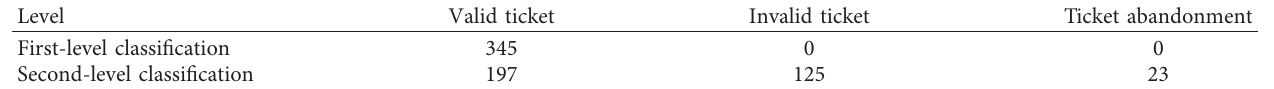
Table 5: Voting results of multitask collaboration.